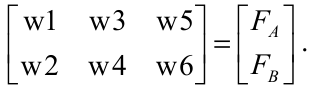
Figure 2. The ANN